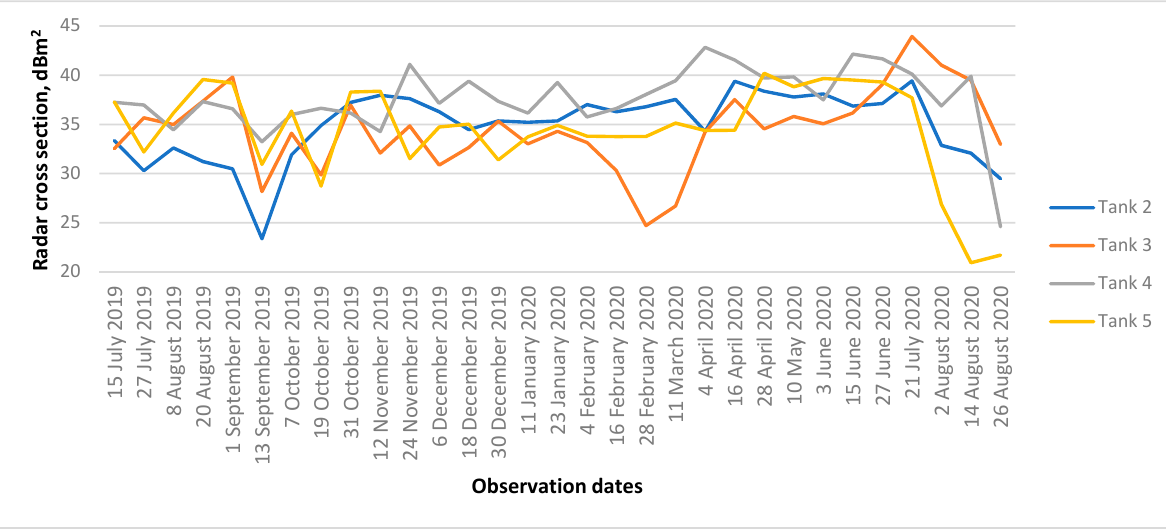
Figure 9. RCS of tanks, dBm 2 , in Sentinel-1 data for 2019–2020.